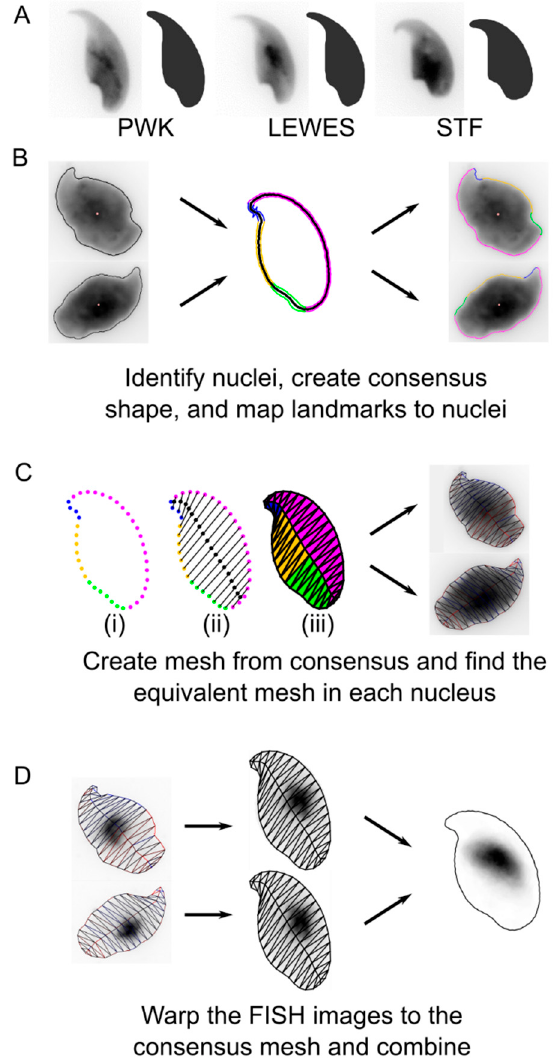
Figure 1. The process of warping fluorescence in ‐ situ hybridisation (FISH) images. ( A ) Examples of un ‐ FISHed nuclei from the three strains, as described in [18]. ( B ) After FISH, nuclei are automatically identified and landmarks are discovered. ( C ) A mesh is created from the consensus nuclear shape; (i) peripheral vertices are evenly spaced between landmarks; (ii) internal vertices divide vertex pairs from the tip; (iii) all vertices are joined. The equivalent mesh is constructed for each nucleus. ( D ) The FISH signal image is transformed to move every pixel to its location in the consensus mesh. The warped images are combined to yield the composite signal image. Mouse strains Mus musculus musculus (PWK), M. m. domesticus (LEWES) and Mus spretus (STF)